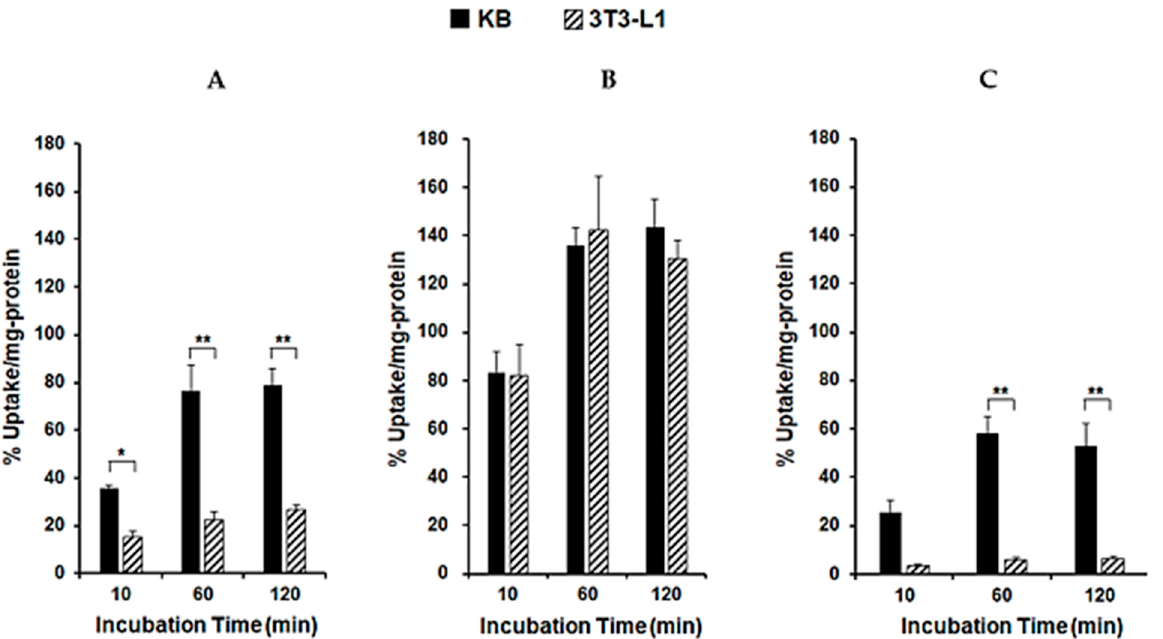
Figure 6. Cellular uptake of 67 Ga-NOTA-KV6 ( A ), 67 Ga-NOTA-RV6 ( B ), and 67 Ga-NOTA-HV6 ( C ) in KB and 3T3-L1 cells. * p < 0.01 and ** p < 0.001 compared with 3T3-L1 cells. (ANOVA Bonferroni’s multiple comparison test). Values are mean ± SEM ( n = 4 − 6).